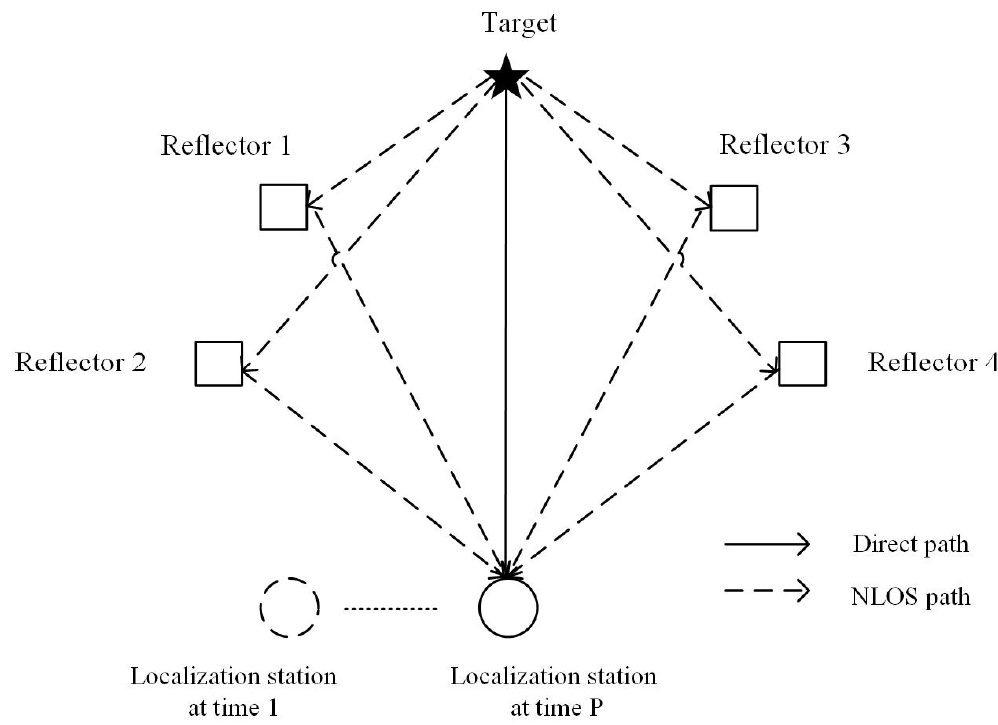
Figure 1. Single re fl ection in multi-path localization scenario. Figure 1. Single reflection in multi-path localization